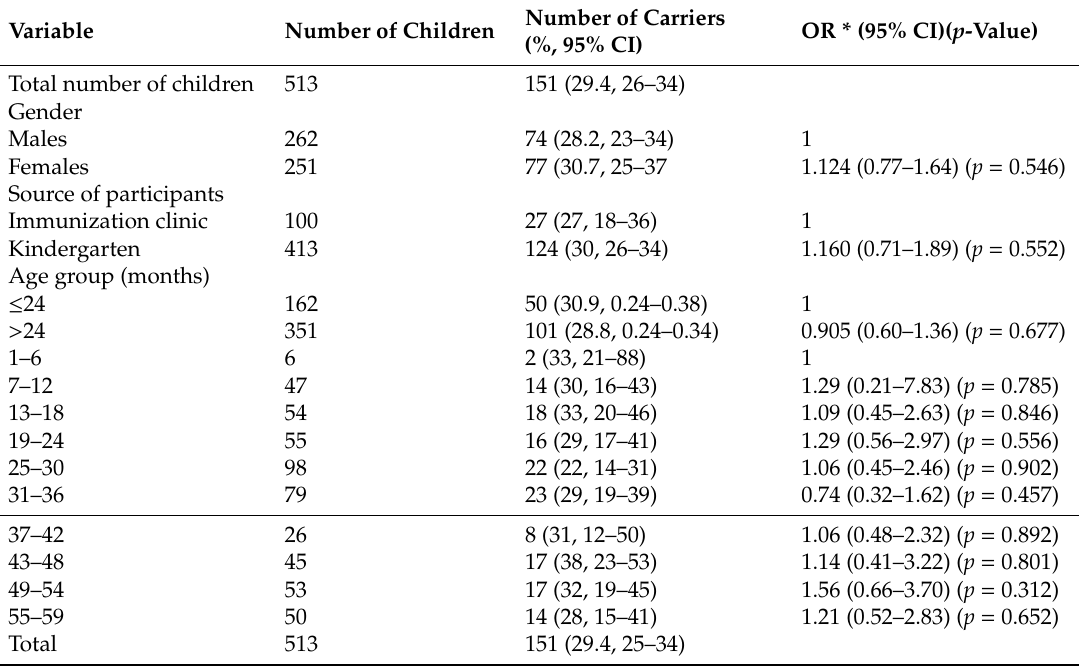
Table 1. Participant characteristics and pneumococcal